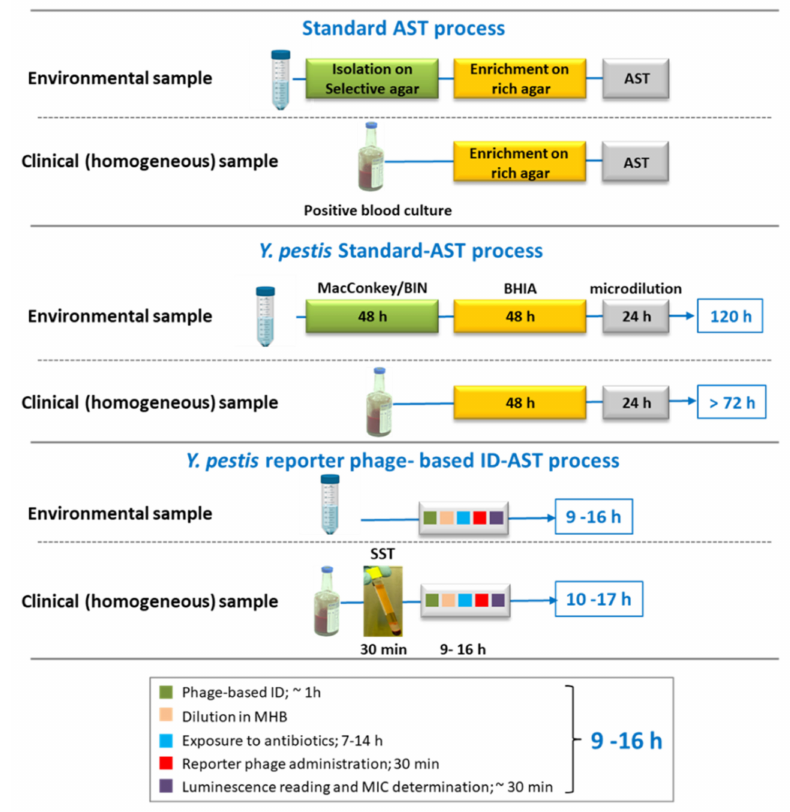
Figure 7. Standard or rapid Y. pestis phage-based ID-AST time